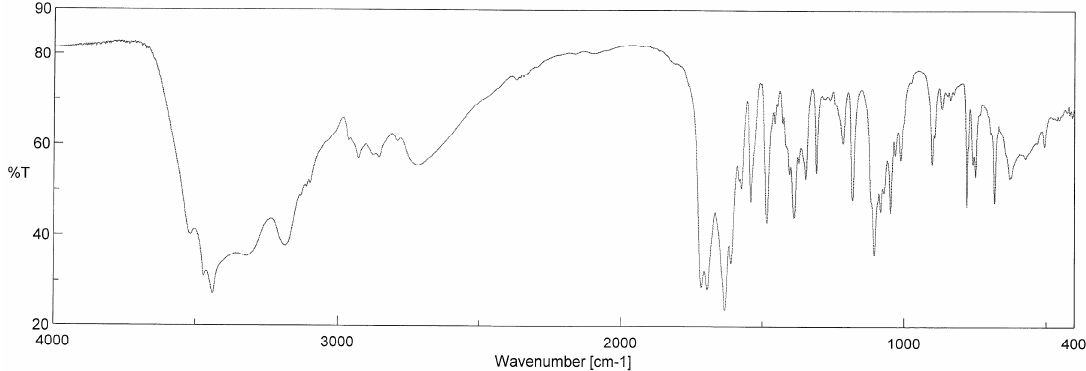
Figure A5. FT-IR spectrum of a commercial sample of acv ⋅ 0.66 H 2 O (KBr disks).